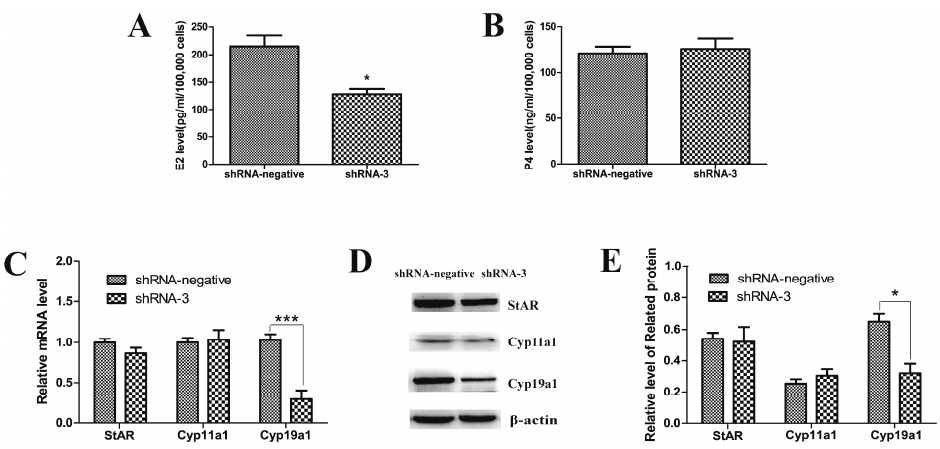
Figure 2. Effects of XBP1 silencing on ( A ) E2 and ( B ) P4 production in mouse GC; ( C – E ) Relative mRNA and protein levels of genes (StAR, Cyp11a1, and Cyp19a1) are detected by real-time PCR and western blotting in mouse GCs after transduction with shRNA-3 and shRNA-negative lentiviruses for 48 h. The analyses of the band intensity are presented as the relative ratio of objective protein to β -actin. Data are shown as the mean ± SEM. Bars with asterisks represent a significant difference (* p < 0.05, *** p < 0.001).